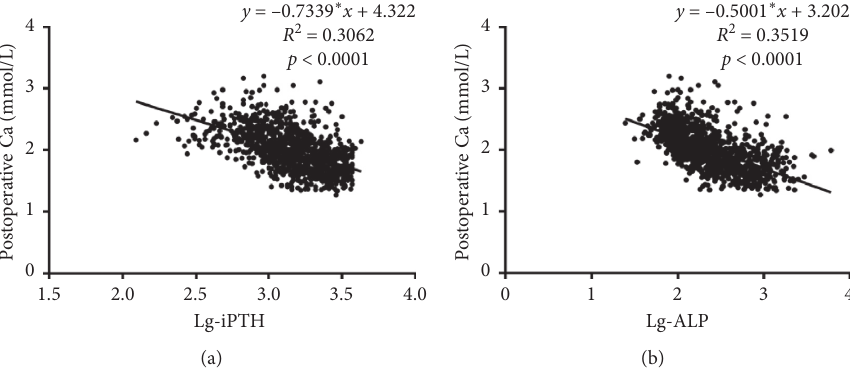
Figure 1: Linear regression of Lg-iPTH, Lg-ALP, and postoperative serum calcium. The linear regression analysis showed Lg-iPTH (a) and Lg-ALP (b) were negatively correlated with postoperative calcium and the correlation coefficients were 0.3062 ( p < 0 . 0001) and 0.3519 ( p < 0 . 0001). Table 3: Logistic regression analysis of the association between risk factors and postoperative severe hypocalcemia. Variable